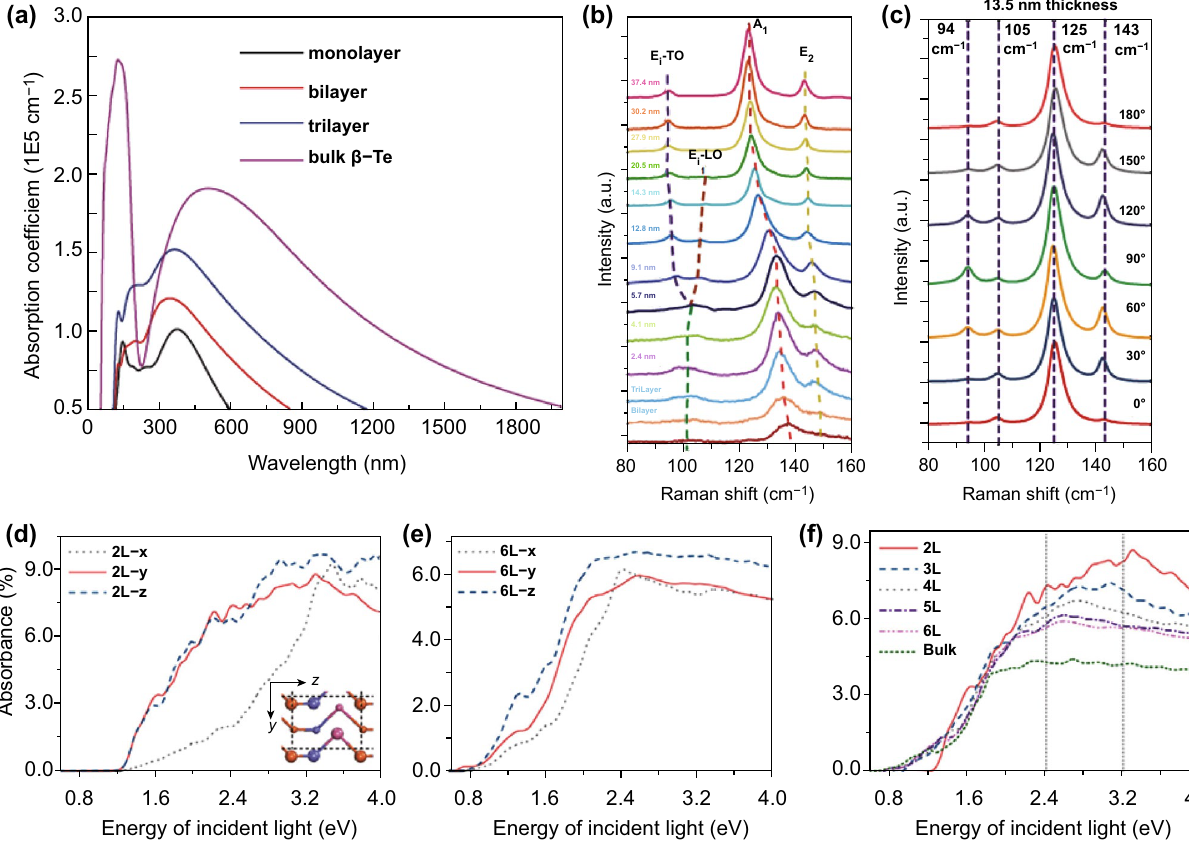
Fig. 8 Optical properties of 2D Te. a Absorption coefficients of the bulk, few‑layer, and monolayer β‑Te. Adapted with permission from [24]. Copyright 2017, IOP Publishing. b, c Raman and angle‑resolved Raman spectra of the 2D Te flakes. Adapted with permission from [25]. Copy‑ right 2018, Nature Publishing Group. d , e Absorbance of 2 layer and 6‑layer α‑Te with the incident light polarization along the x ‑, y ‑, and z ‑direction. f Absorbance of incident light polarized in the direction for few‑layer α‑ and bulk Te. Adapted with permission from [64].